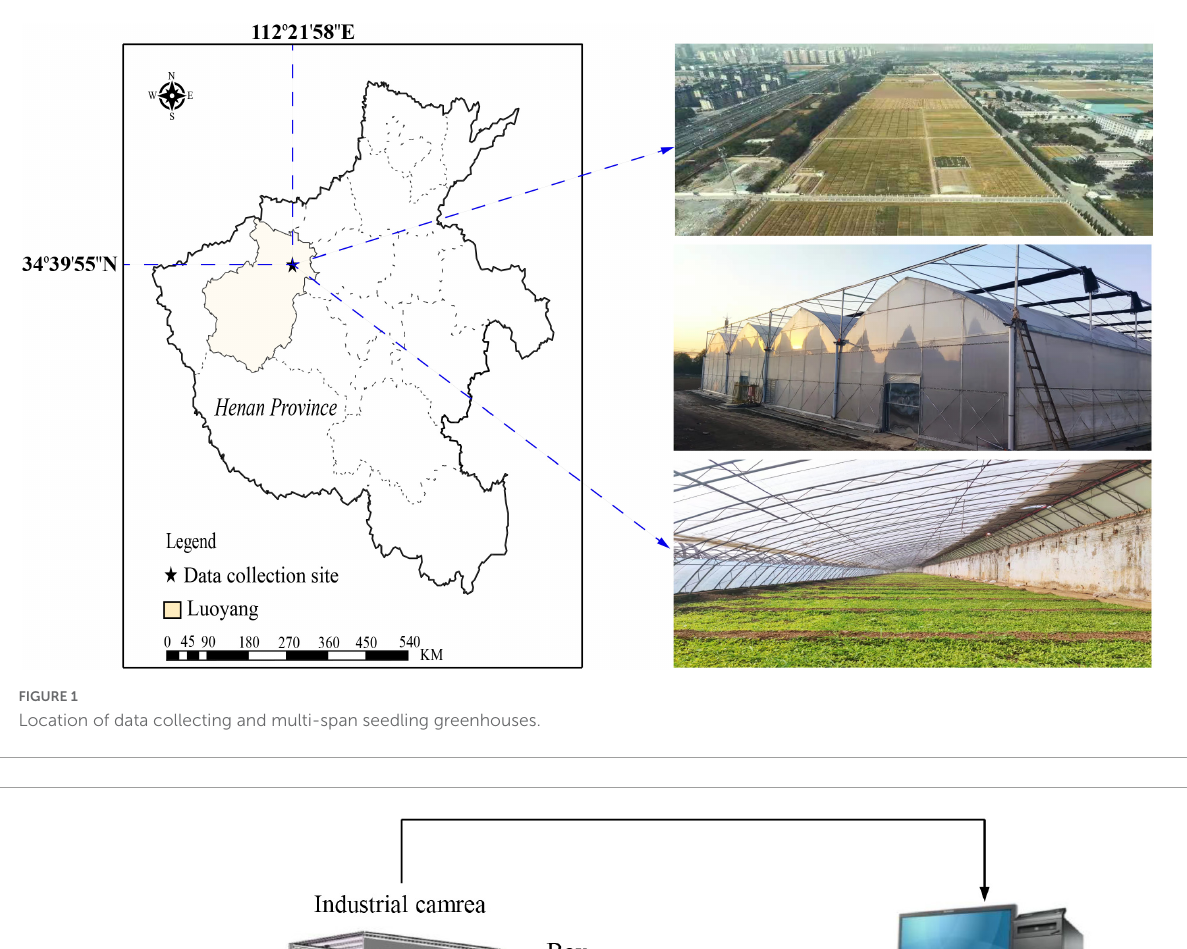
FIGURE1 Location of data collecting and multi-span seedling greenhouses.